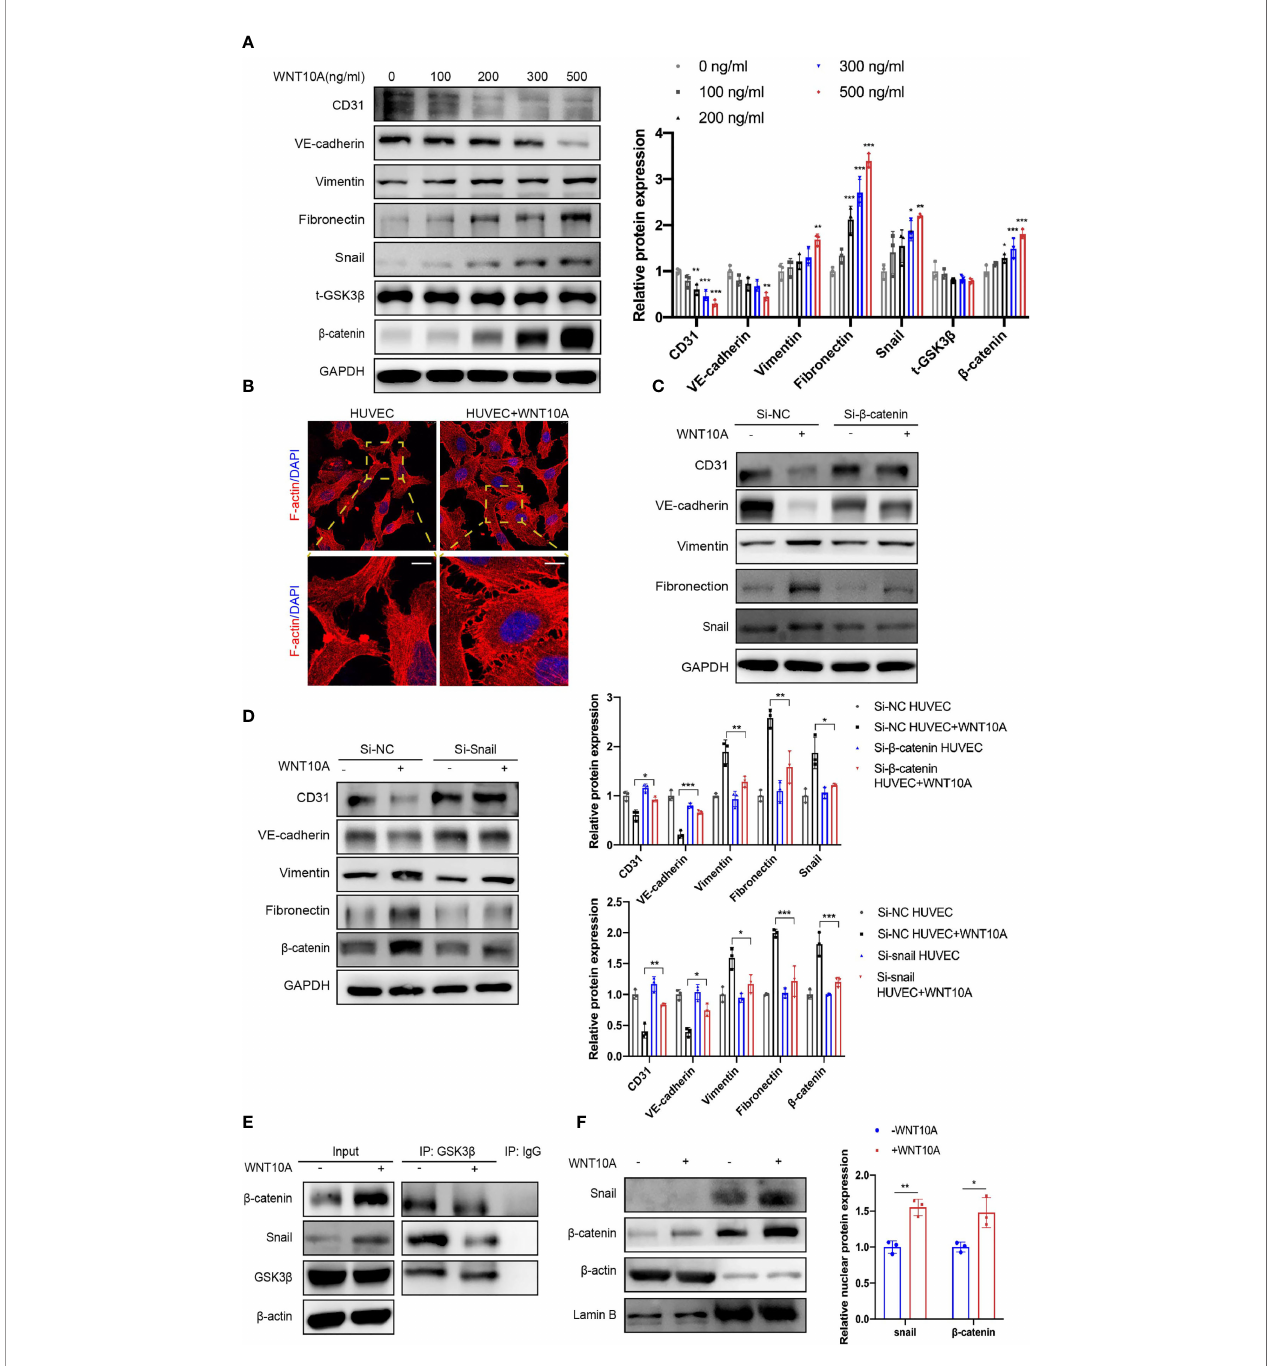
FIGURE 5 | WNT10A prompted EndMT via GSK3 b / b -catenin/snail signaling. (A) HUVECs were treated with different concentrations of WNT10A, and expression of EndMT markers was determined by immunoblot (n = 3 independent experiments). Error bars, SD. * p < 0.05, ** p < 0.01, *** p < 0.001 vs. control. (B) The effects of WNT10A on the cytoskeleton rearrangement of HUVECs through F-actin staining. Scale bar, 10 m m; n = 3 independent experiments. (C, D) Immunoblot analysis of EndMT markers in control group and b -catenin (C) or snail (D) knockdown HUVECs with or without WNT10A treatment (n = 3 independent experiments). Error bars, SD. * p < 0.05, ** p < 0.01, *** p < 0.001. (E) Co-IP analysis showed the interaction between GSK3 b and b -catenin/snail in HUVECs. GSK3 b , b -catenin, and snail were immunoprecipitated by antibodies against GSK3 b . Antibody against IgG was used as a negative control. n = 3 independent experiments. (F) Cytoplasmic and nuclear extracts of HUVECs were separated. Protein levels of b -catenin and snail were analyzed by immunoblot. Cytoplasmic marker b -actin and nuclear membrane marker lamin B were used as loading controls (n = 3 independent experiments). Error bars, SD; * p < 0.05, ** p < 0.01. EndMT, endothelial-to-mesenchymal transition; HUVEC, human umbilical vein endothelial cell; Co-IP,